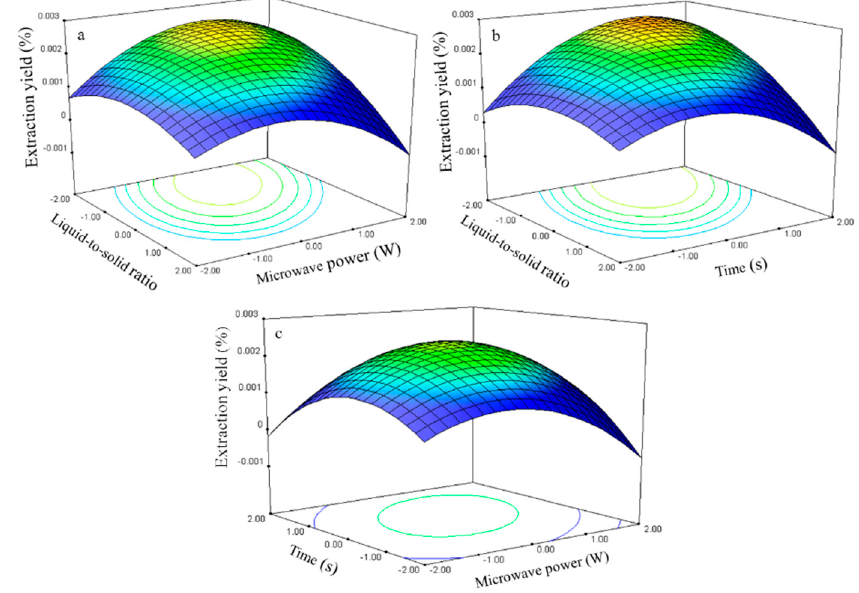
Figure 9. Response surface plots for the effects of: ( a ) liquid-to-solid ratio/power ( b ) liquid-to-solid/time ( c ) power/time on the extraction yield of genistein.